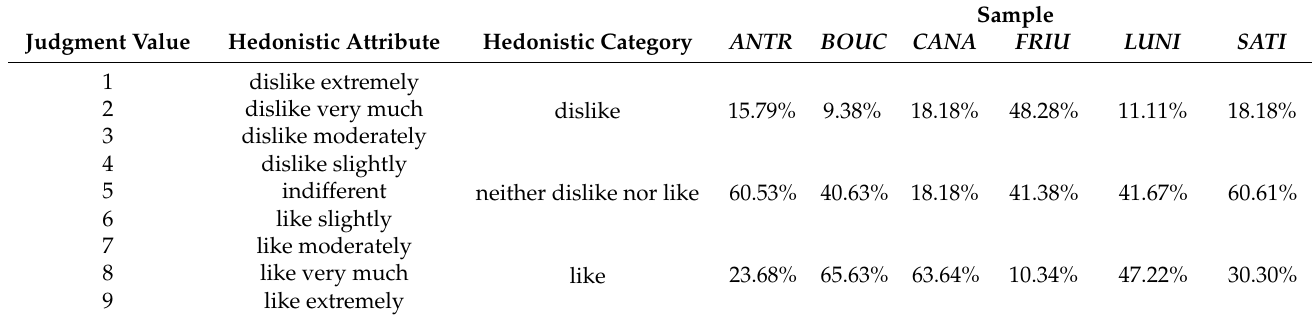
Table 5. Frequencies related to the consumer judgment for the cookies derived from the analysed chestnut